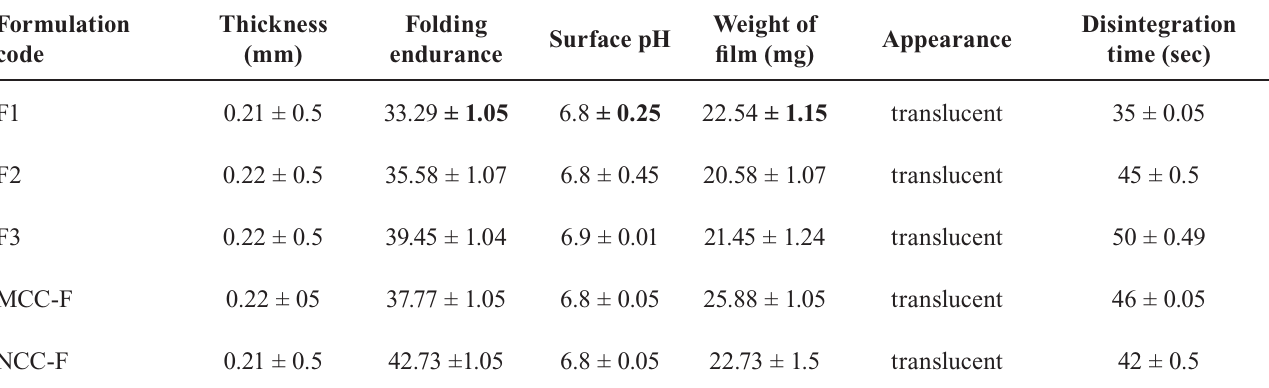
TABLE II - Physical evaluation parameters of ODF formulation